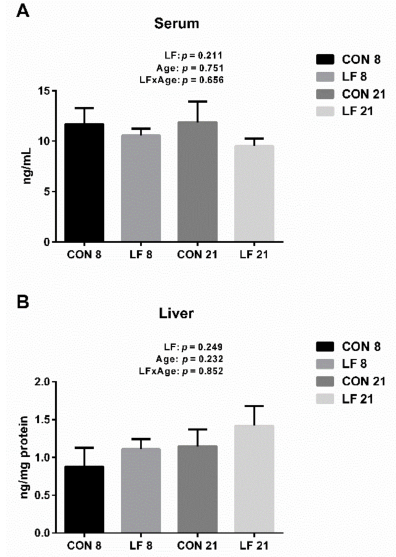
Figure 3. E ff ects of lactoferrin on hepcidin levels in the serum ( A ) and liver ( B ) of suckling piglets. Values are means, standard errors represented by vertical bars, n = 6 per treatment. Control group on day 8 (CON 8); Lactoferrin group on day 8 (LF 8); Control group on day 21 (CON 21); Lactoferrin group on day 21 (LF